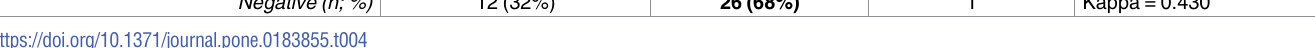
Table 5. Univariate association of 7 tesla magnetic resonance imaging (7T MRI) characteristics and postoperative indication for systemic therapy. A significant(p < 0.05 * )association is seen between the postoperative indicationfor systemic therapy and dynamic contrast-enhanced(DCE)-MRI as well